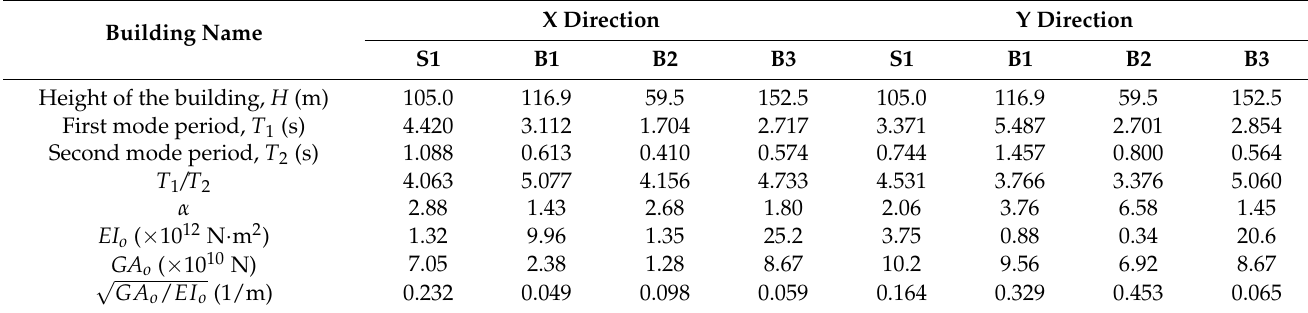
Table 4. Structural indexes and α of the four case study